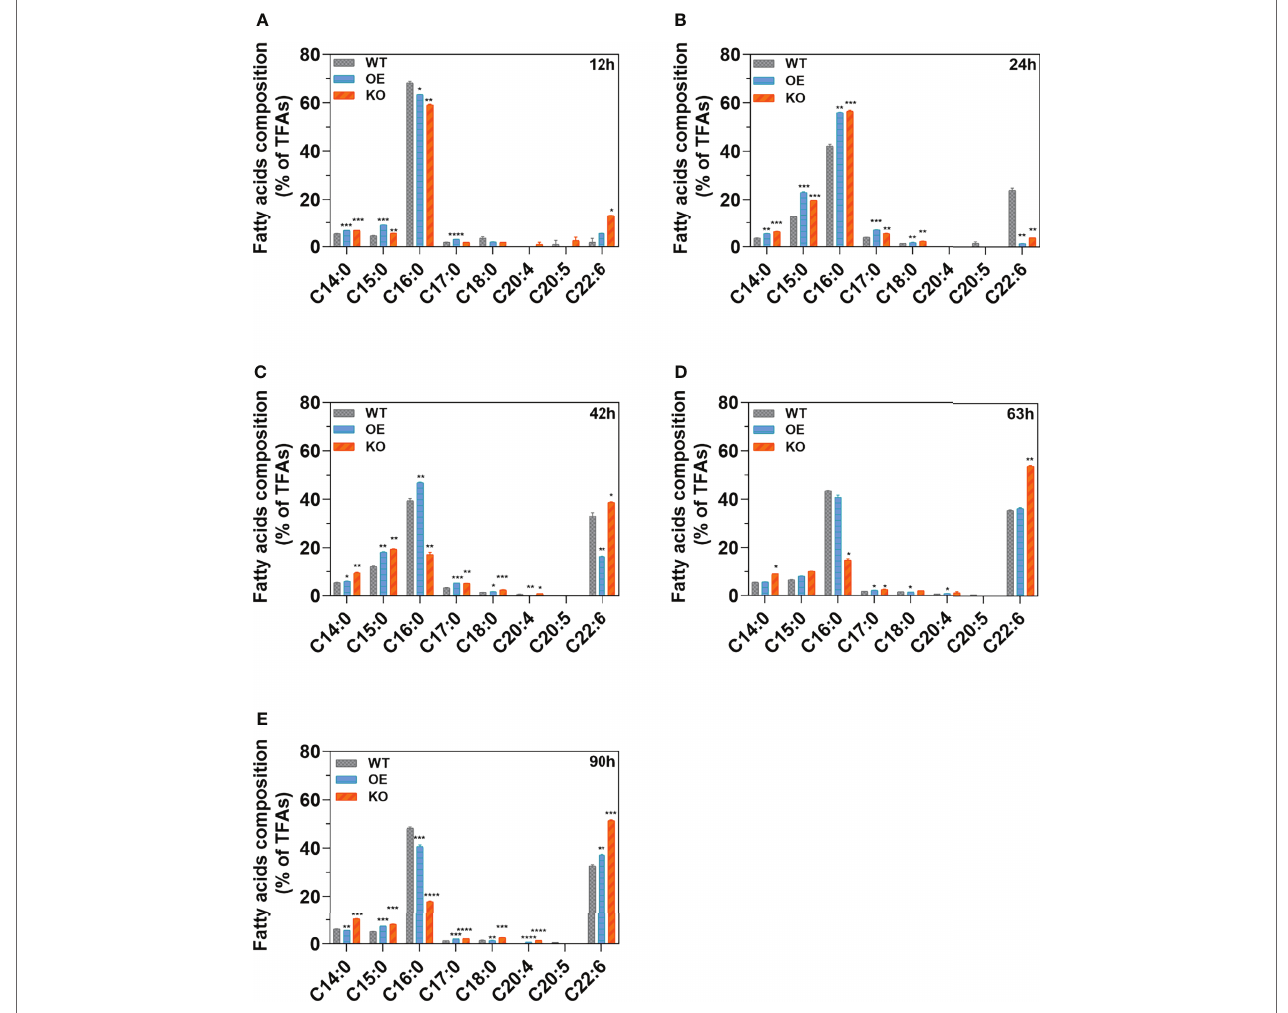
FIGURE 4 | Fatty acid composition in various growth stages. (A–E) indicate the fatty acid composition of the wildtype (WT) strain, DECR overexpression (OE), DECR and knockout (KO) transformants detected by GC-MS after 12 h, 24 h, 42 h, 63 h, and 90 h, respectively. Data are shown as the percentage of total fatty acids (TFAs). C14:0, tetradecanoic acid; C15:0, pentadecanoic acid; C16:0, hexadecanoic acid; C17:0, heptadecanoic acid; C18:0, octadecanoic acid; C20:4, eicosatetraenoic acid; C20:5 eicosapentaenoic acid; C22:6, docosahexaenoic acid. Significant difference between wildtype strain (WT) and transformants (OE and KO) indicated at the p < 0.05 (*), p < 0.01 (**), p < 0.001 (***), or p < 0.0001 (****) level. All data are expressed as the mean ± S.D. of three independent